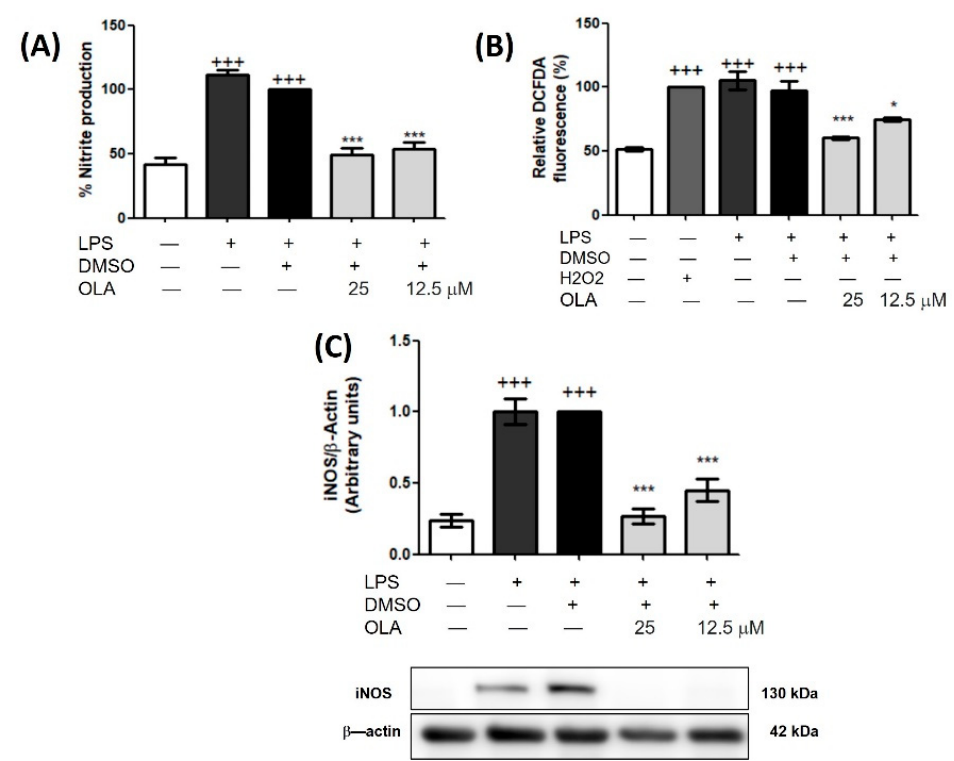
Figure 2. OLA downregulated ROS production, nitrites production, and iNOS protein expression in murine peritoneal macrophages. Cells were pretreated with different concentrations of OLA (25 and 12.5 µ M) and then stimulated with LPS for 18 h. ( A ) Nitrite production; ( B ) ROS production; ( C ) Western blot analysis of iNOS protein expression. Densitometry was performed following normalization to the control ( β -actin housekeeping gene). Data are represented as means ± SEM ( n = 6). (+++) p < 0.001 vs. control cells (no stimulated). *** p < 0.001 vs. LPS-MSO-treated cells. Nitrites measurement was used as an indicator of NO production. Like the DCFDA signal, nitrites generation increased in the presence of LPS (+++ p < 0.001 vs. unstimulated cells). Nonetheless, pretreatment with OLA displayed a significant reduction of